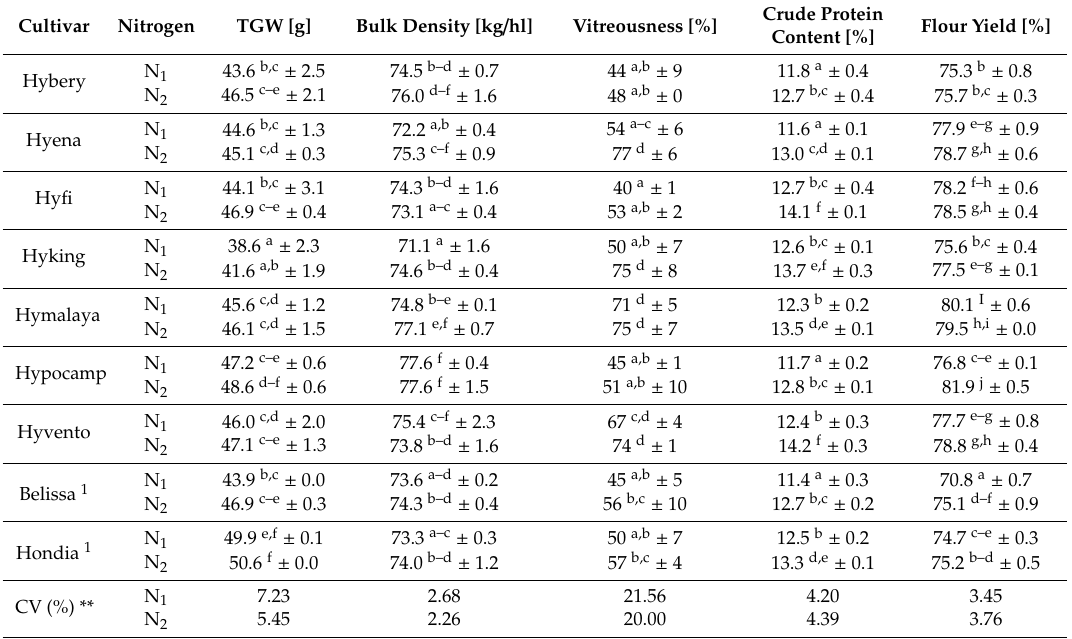
Table 1. Selected qualitative indicators of wheat grain and flour from hybrid and population cultivars.